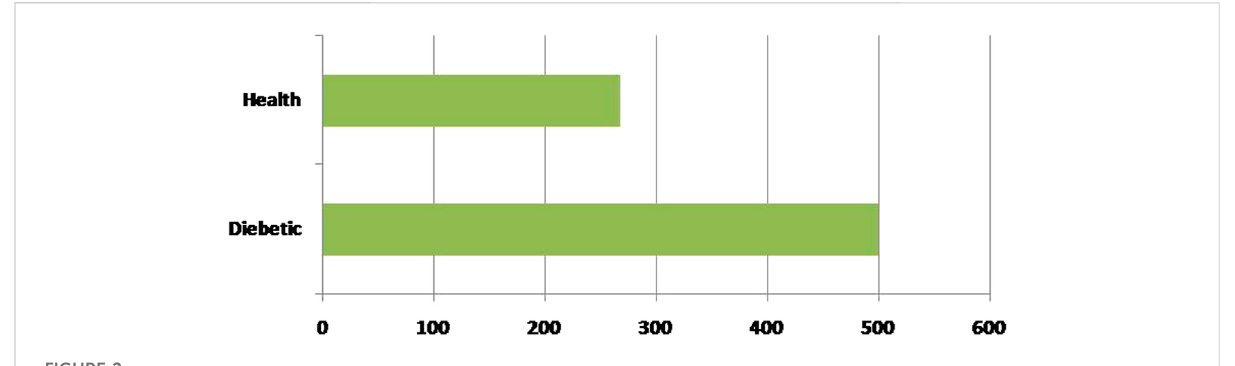
FIGURE 2 The count of healthy and unhealthy (diabetes) in the dataset.